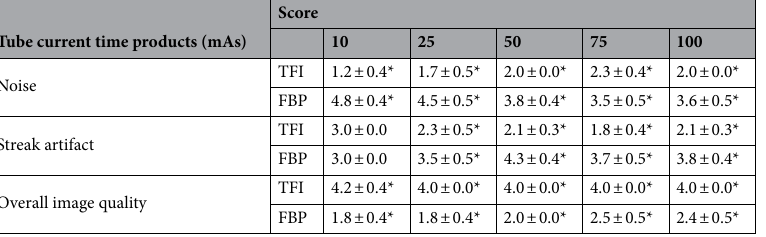
Table 3. Subjective comparison of TFI and FBP at the same tube current–time products: CT findings. Scores are presented as mean ± SD. Scores of subjective image analysis were statistically analyzed using the Mann– Whitney’s U test. *There was a significant difference between TFI and FBP at the same tube current–time products ( p < 0.05).